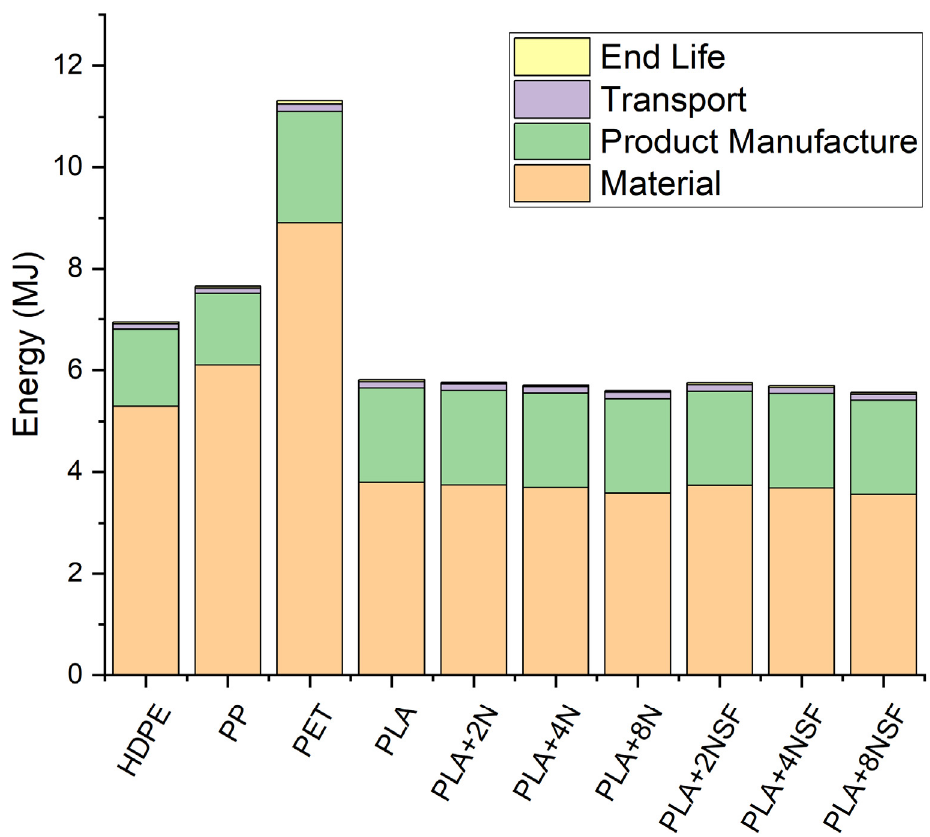
Figure 13. LCA results in terms of energy.